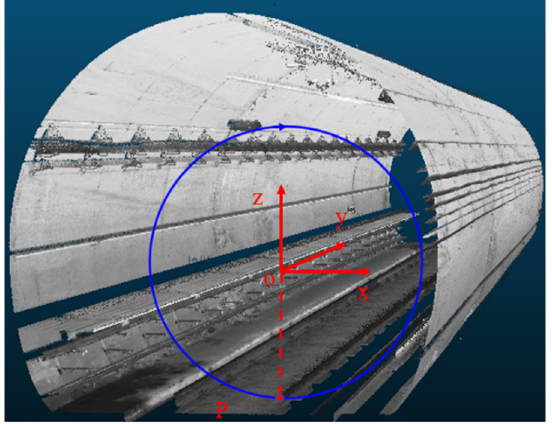
Figure 5. Tunnel 3D coordinate system.